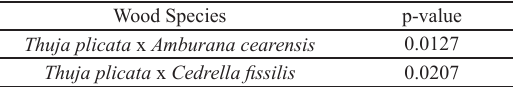
Table 5. Relation between mean value for contact angle for wettability.